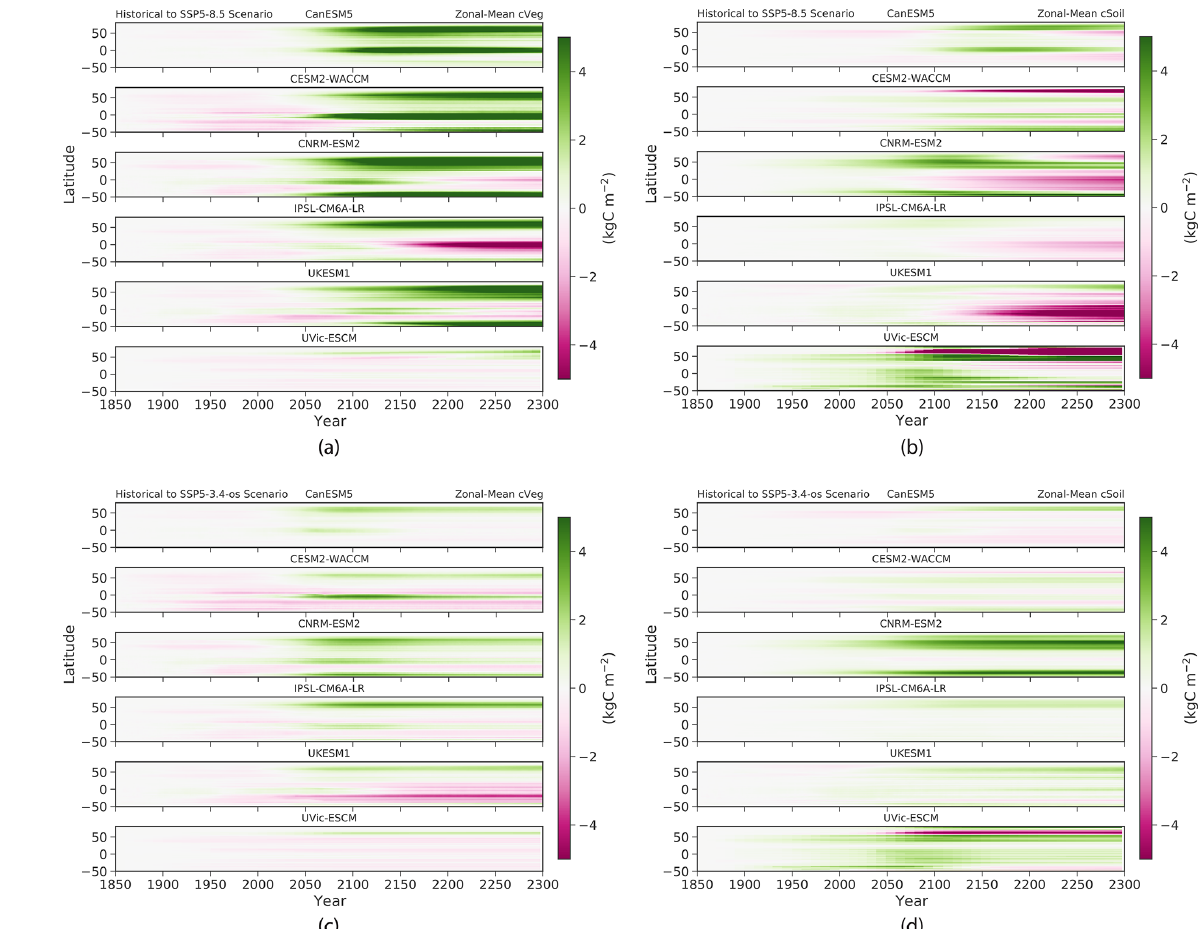
Figure 6. Zonal mean changes to terrestrial vegetation (a, c) and soil carbon stocks (b, d) in the six models for SSP5-8.5 and SSP5-3.4- overshoot scenarios ( a , b–c , d ,